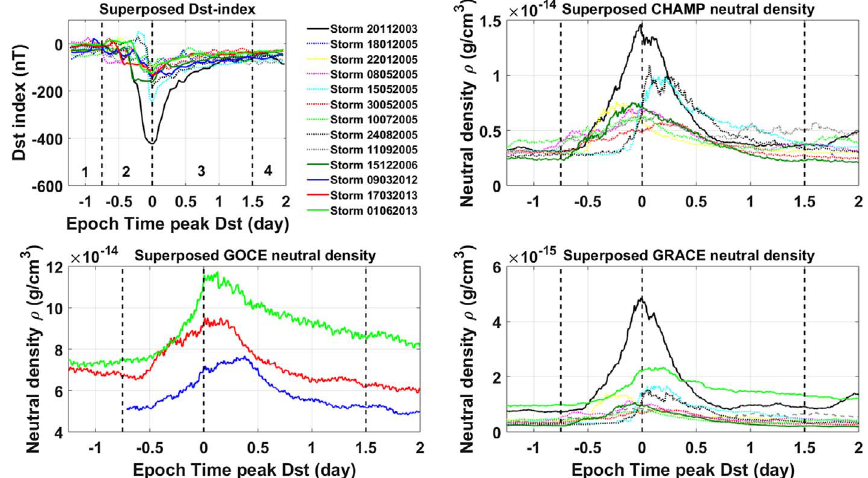
Fig. 2. Dst (top) and densities, smoothed over one orbit in a moving window, for the selected storms, centered on t 0 , for CHAMP, GRACE and GOCE.